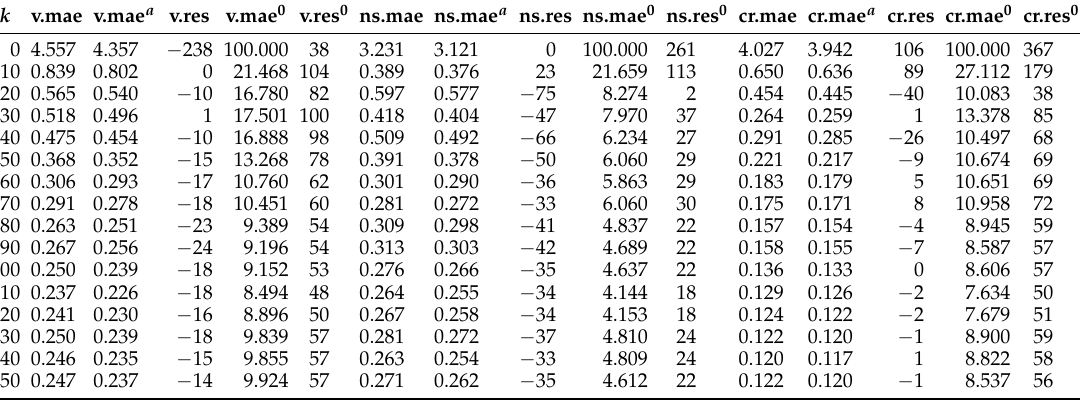
Table A4. Out-of-sample validation figures of the OLS proxy function of BEL under 150–443 after each tenth iteration.